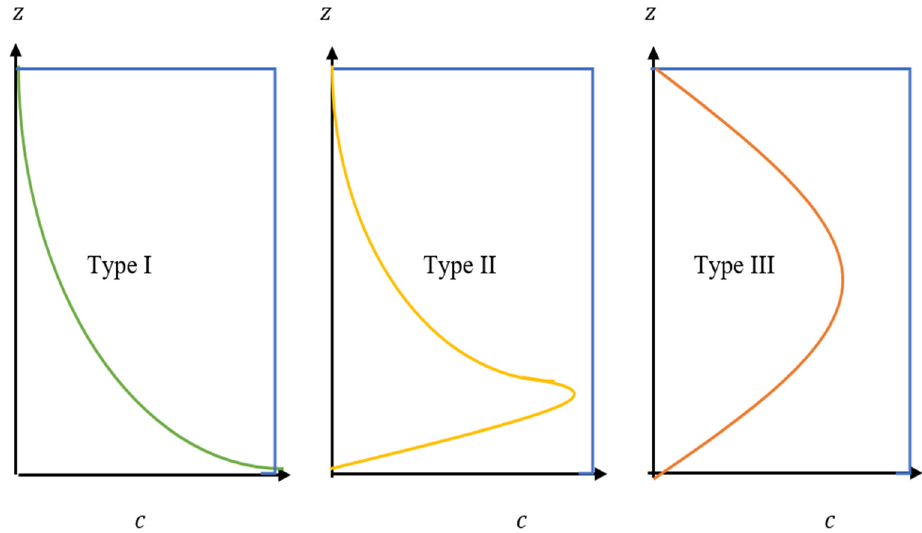
Figure 2. Type I, II, and III concentration distributions along with the depth.